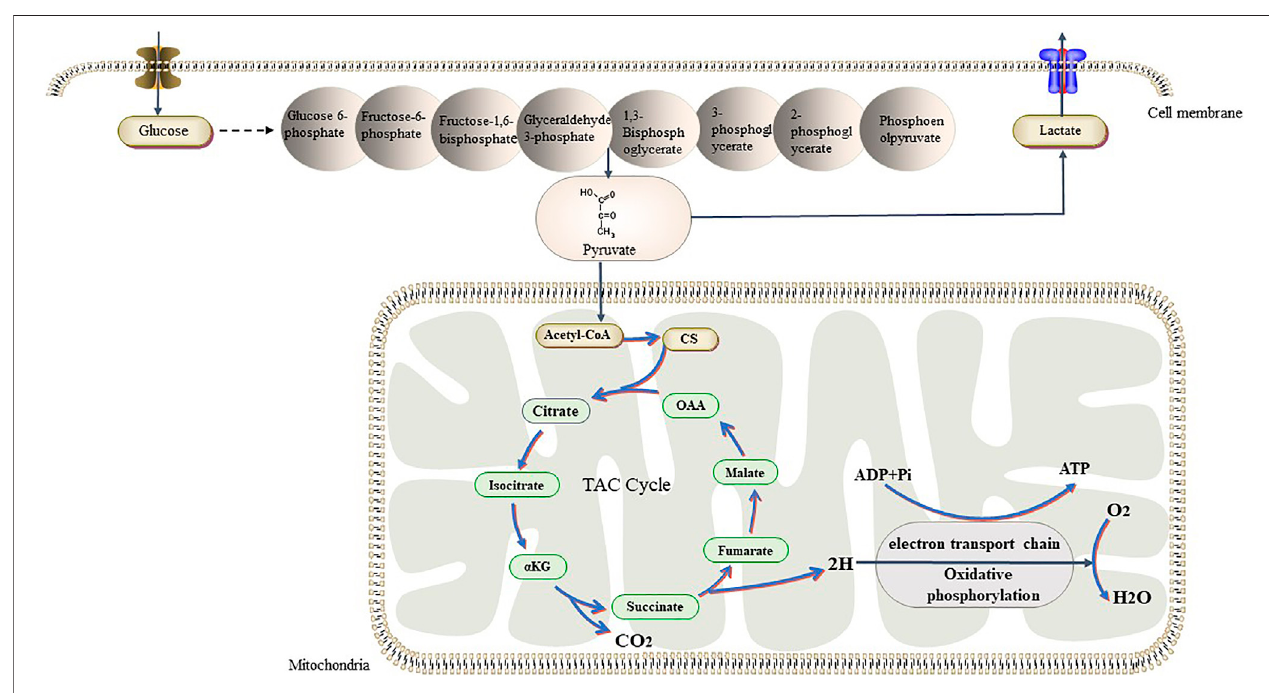
FIGURE 3 | Tumor cells have different ways of glucose metabolism from normal cells. In the presence of suf fi cient oxygen, they also prefer glycolysis, while normal cells prefer aerobic glucose oxidation. Recent studies have shown that tumors can switch back and forth between aerobic glycolysis and oxidative phosphorylation in response to their own proliferative needs. Abbreviations: α KG, α -Ketoglutraic acid; Cd, Citrate synthase; OAA, Oxaloacetic acid.